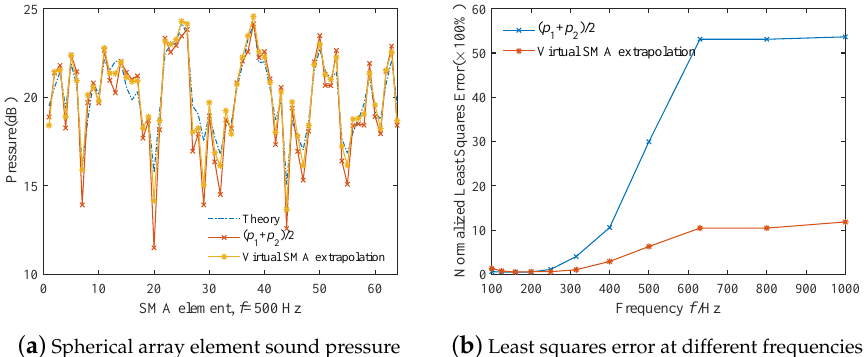
( b ) Least squares error at different frequencies Figure 3. Calculation and comparative analysis of sound pressure at velocity point.